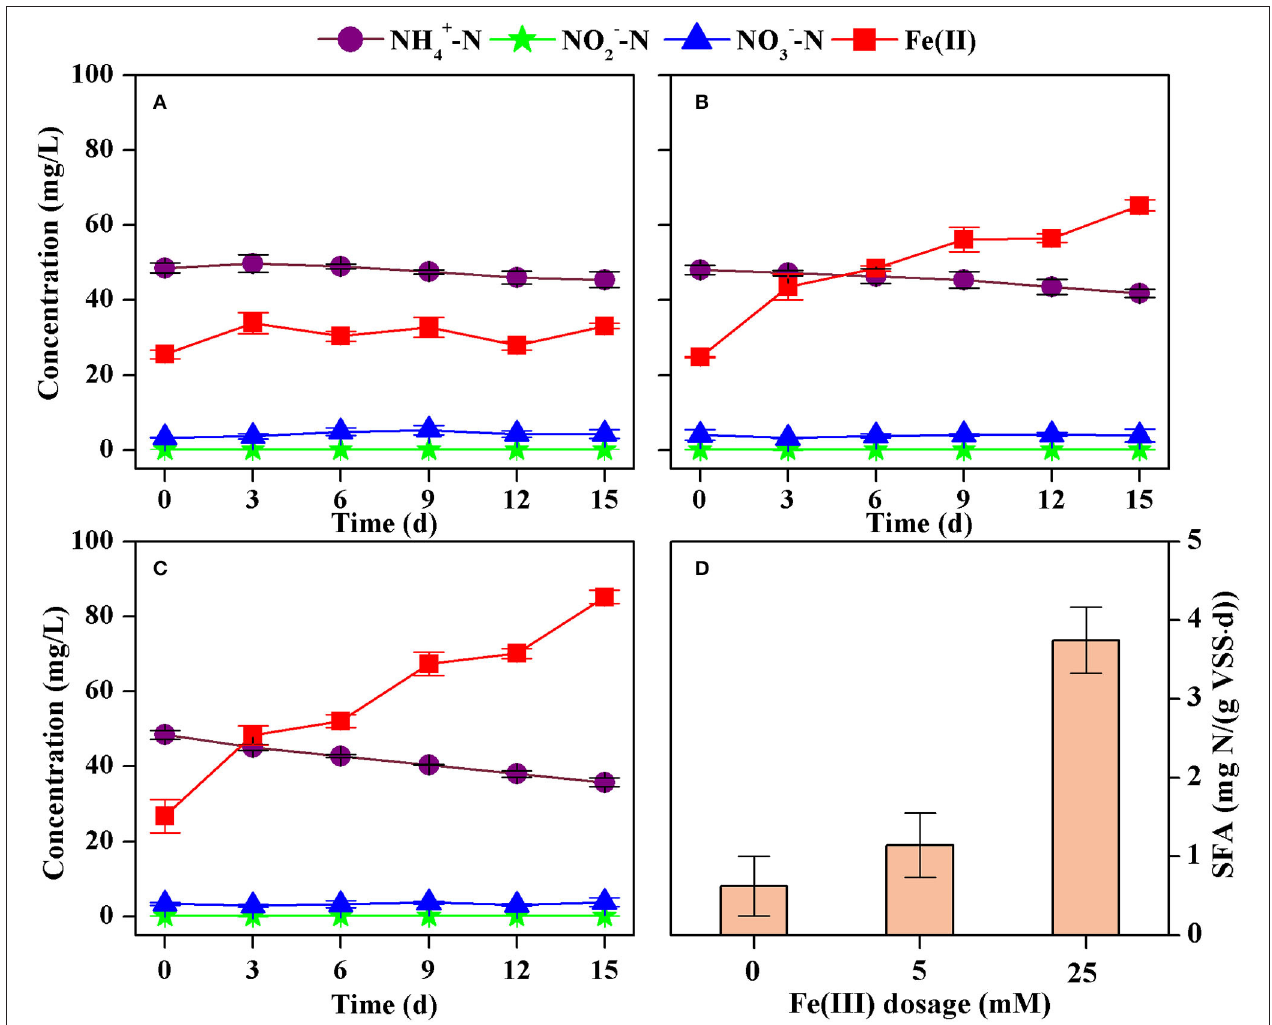
FIGURE 5 | Concentrations of ammonium, nitrite, nitrate, and Fe(II) in the batch tests dosed with Fe(III) at 0mM (A) , 5mM (B) , 25mM (C) , and the estimated specific Feammox activity of ammonium oxidation (D) .